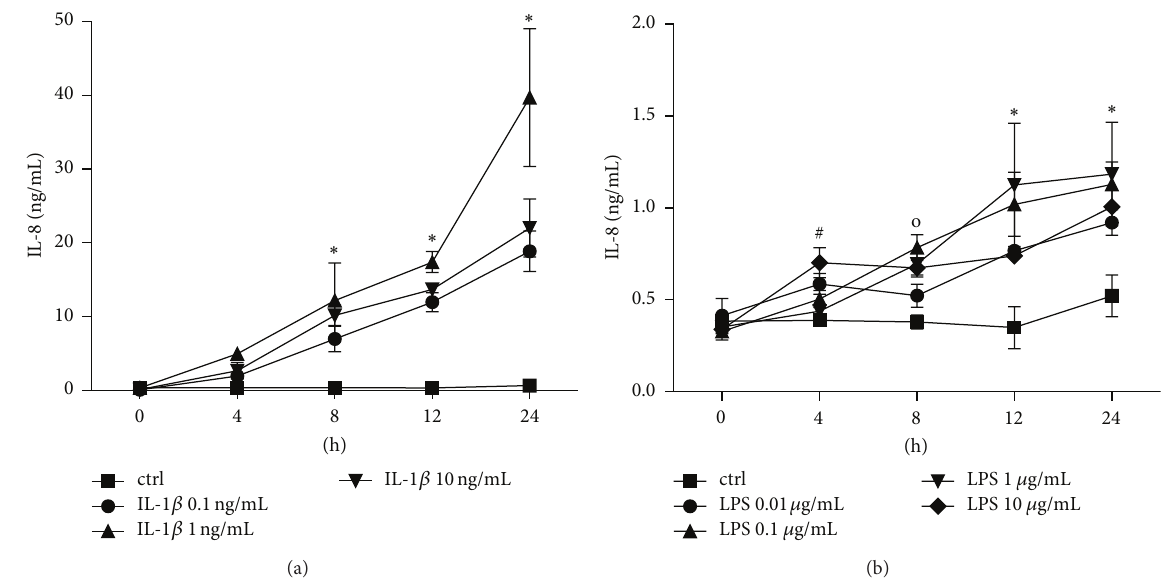
Figure 1: Interleukin (IL)-8 release from lung epithelial cells A549 after IL-1beta (a) or lipopolysaccharide (LPS (b)) stimulation. Cells were stimulated with IL-1beta or LPS in indicated concentrations for different intervals (incubation time indicated below the 𝑥 -axis). After the incubation periods, supernatants were analyzed for IL-8 concentrations. The data are presented as means ± s.e.m. ∗ 𝑃 < 0.05 , all groups versus corresponding control (ctrl); # 𝑃 < 0.05 , LPS 10 𝜇 g/mL versus corresponding ctrl; o 𝑃 < 0.05 , all groups except LPS 0.01 𝜇 g/mL versus corresponding